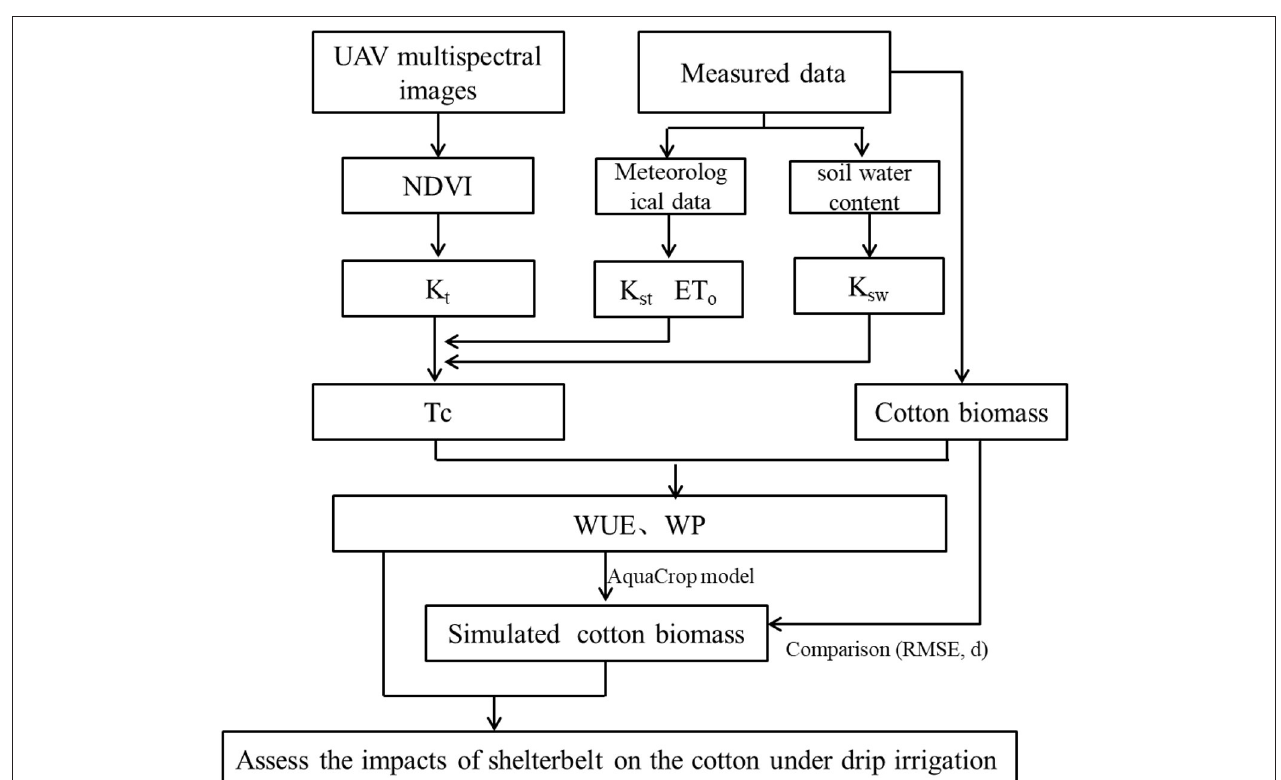
FIGURE 1 | Flow chart of estimation of water use efficiency by constructing a model based on the unmanned aerial vehicle based remote sensing.